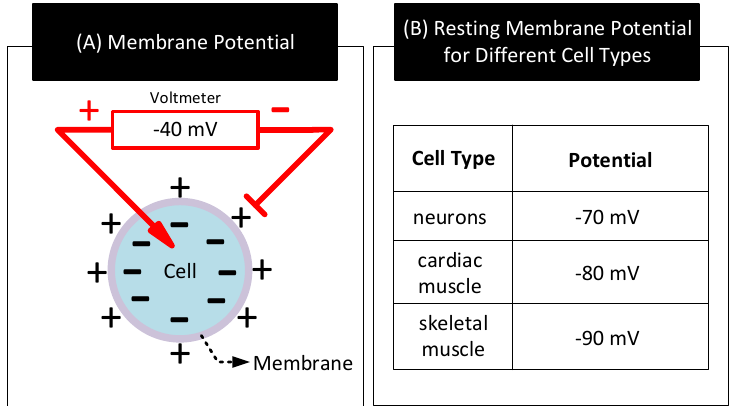
Figure 11. ( A ) A cell’s membrane potential. ( B ) Membrane potential values for three different cell types in their resting state [1,79].